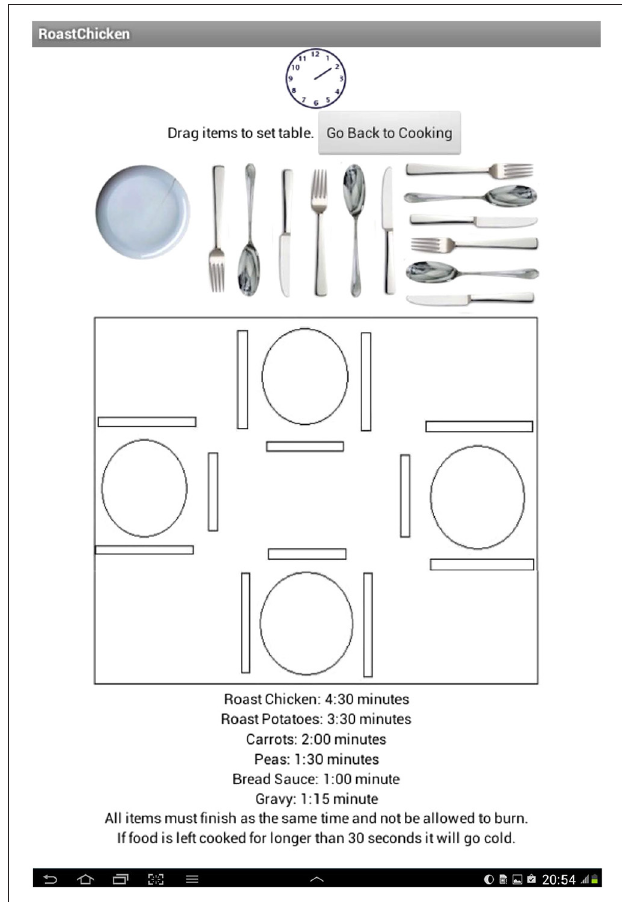
FIGURE 2 | Table setting with the bank of items (plates; knives; forks and